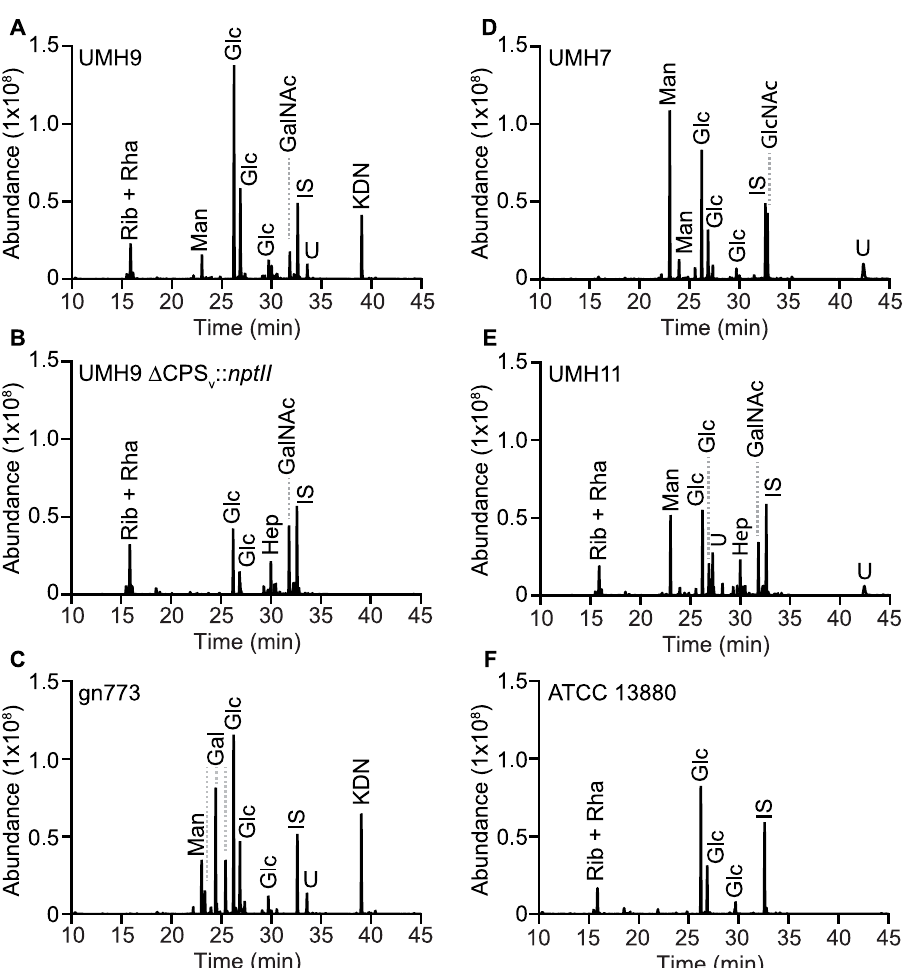
Fig 10. GC-MS of CPS purified from S . marcescens strains. (A-F) Trimethylsilyl derivatives of CPS monosaccharides were detected by GC-MS. Inositol (1 μ g) was included in each run as an internal standard (IS). The ribose and rhamnose peak that appears in some samples is not resolved under the tested conditions. Abbreviations: Gal, galactose; GalNAc, N -acetylgalactosamine; Glc, glucose; GlcNAc, N -acetylglucosamine; Hep, heptose; KDN, ketodeoxynonulonic acid; Man, mannose; Rha, rhamnose; Rib, ribose; U,